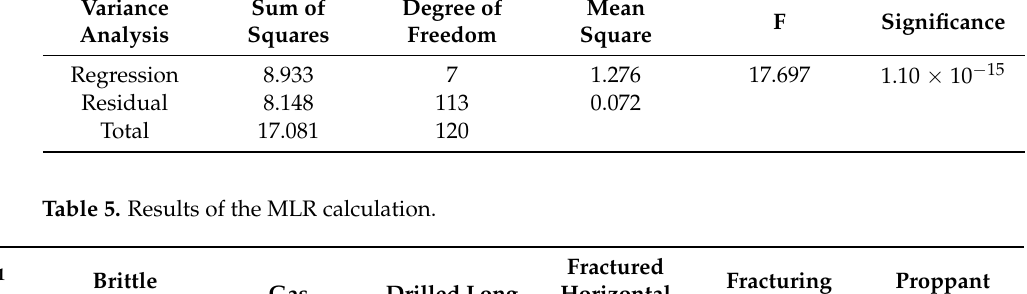
Table 4. Variance analysis of the MLR model.